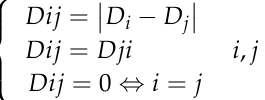
Table 2. Matrix of distance.